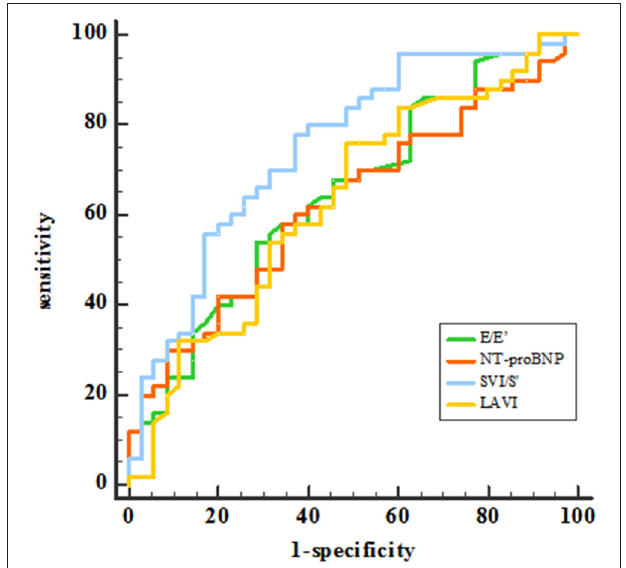
FIGURE 2 | ROC analysis showed the SVI/S’, E/e’, LAVI and NT-proBNP diagnosing ability. SVI/S’, the ratio of body surface area standardized stroke volume (SVI) and tissue Doppler mitral annulus systolic peak velocity; E/e’, the ratio of early diastolic transmitral velocity to early diastolic septal myocardial velocity; LAVI, left atrial volume index; NT-proBNP, N-terminal pro-brain natriuretic peptide.